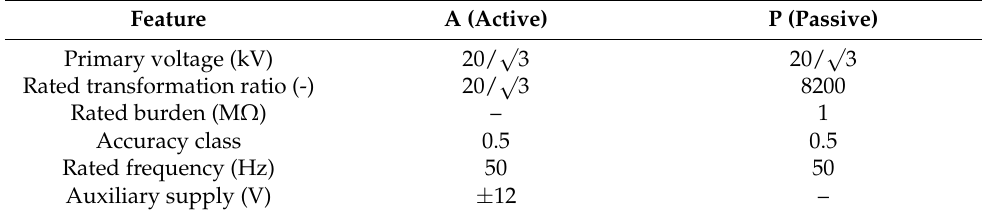
Table 2. Main characteristics of the two LPVTs under